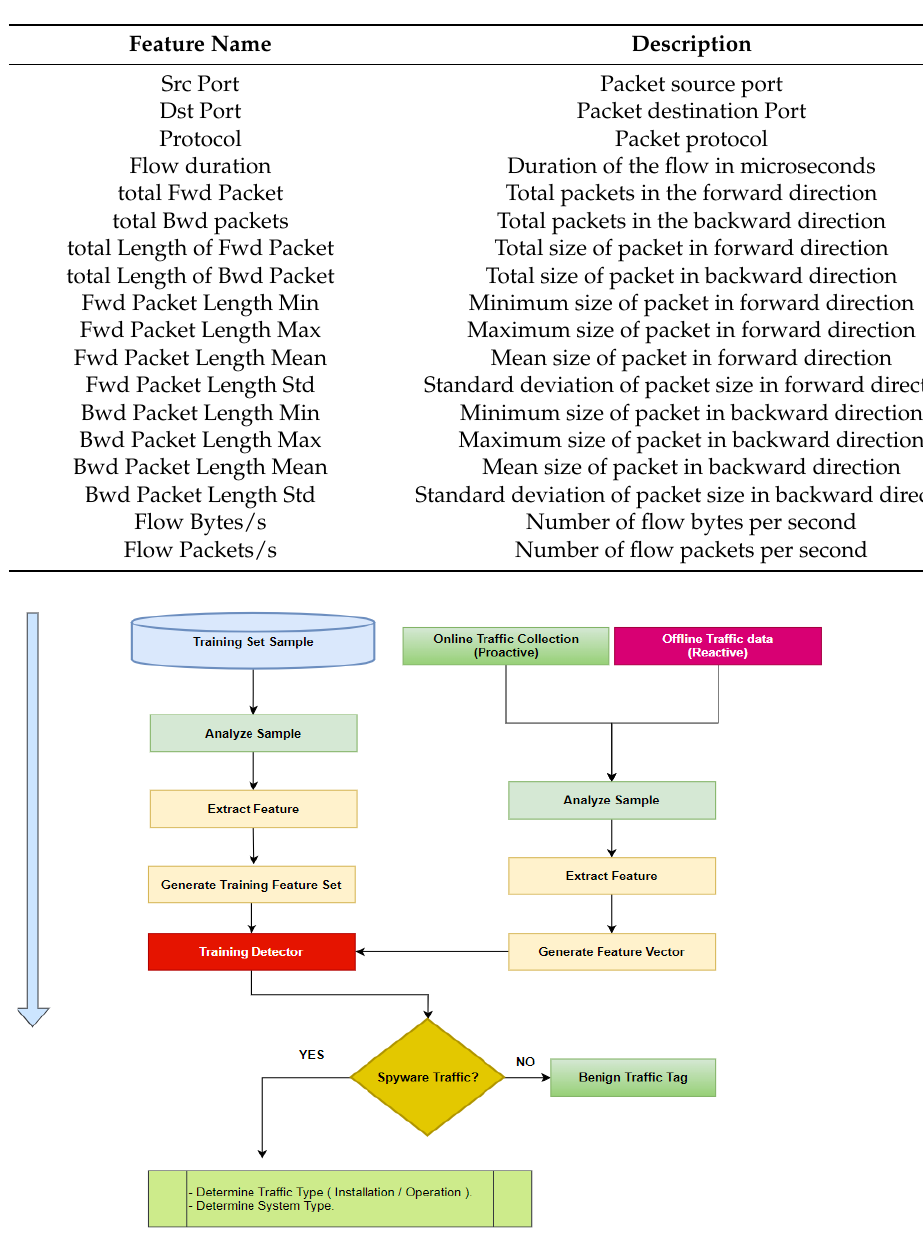
Table 10. Network traffic features set.